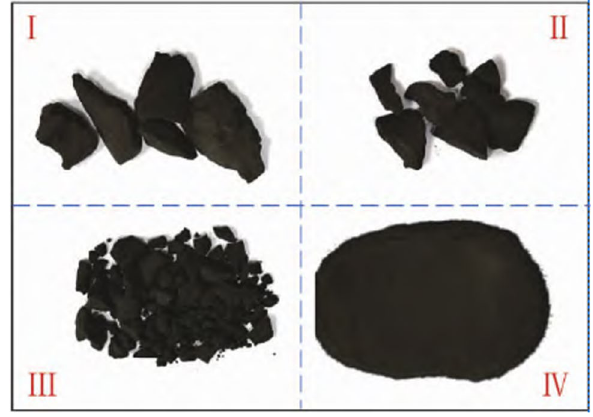
Fig. 12 Fragmentation distribution of 3DP samples under dynamic mechanical testing (Jiang et al. 2022)